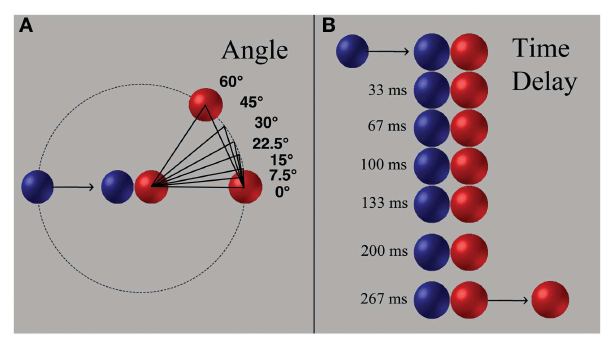
FIGURE 1 | (A) Parametric manipulations of spatial continuity and (B) temporal contiguity common to all experiments. Balls on the left were blue ( r = 14, g = 5, b = 223), balls on the right were red ( r = 255, g = 0, b = 0), and the background was gray ( r = 192, g = 192, b =